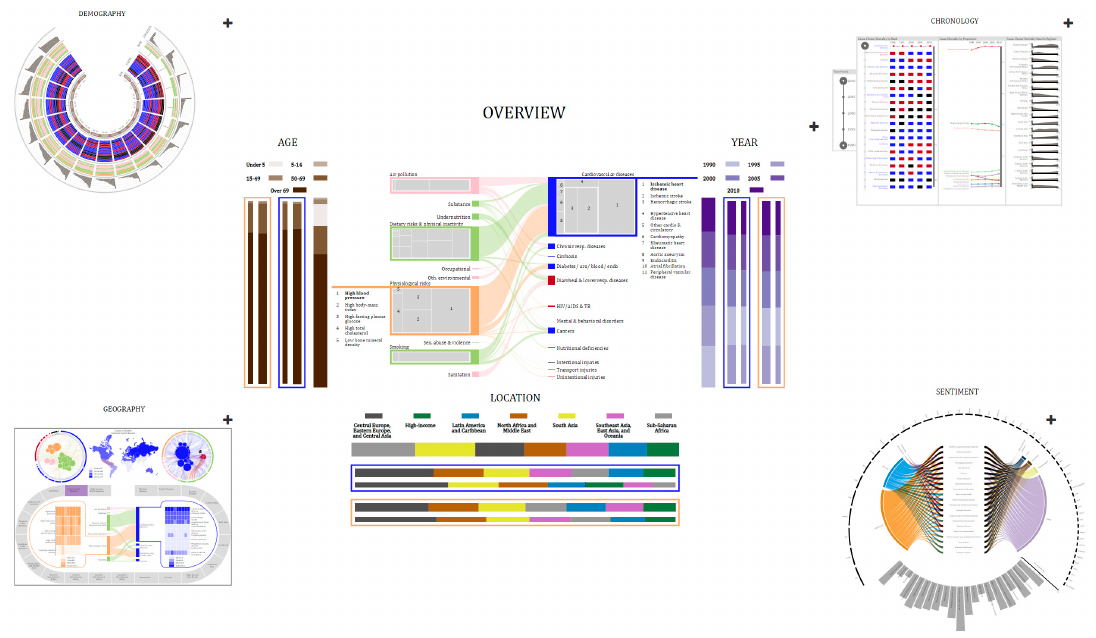
Figure 1. HealthConfection visualization tool.